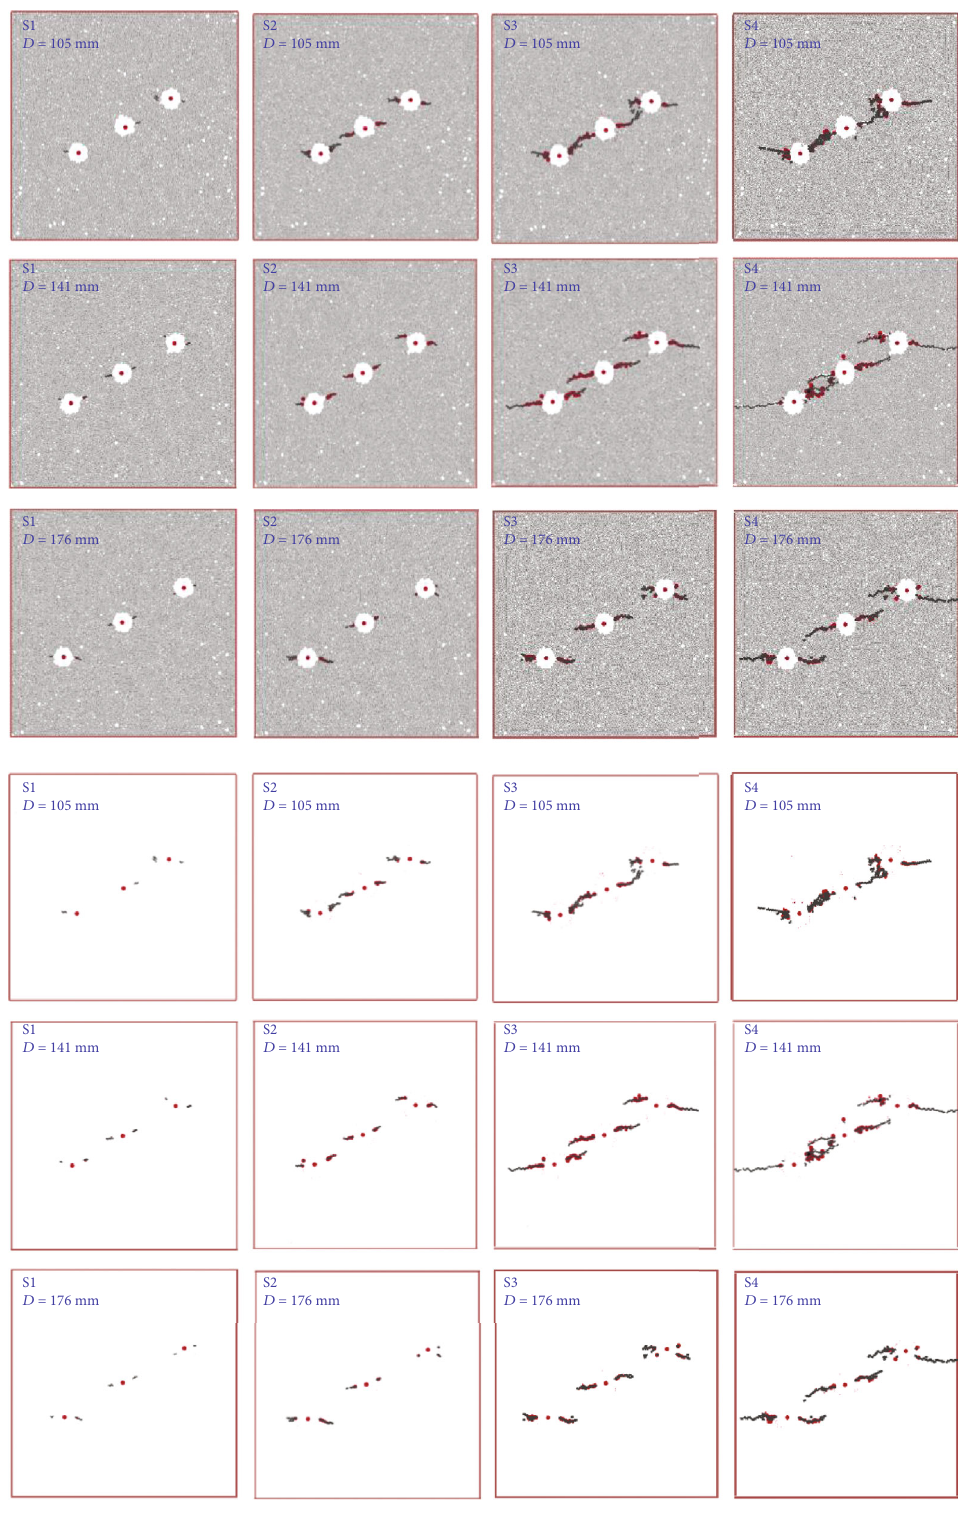
Figure 15: Initiation and propagation process of directional hydraulic fractures at di ff erent borehole direction of the maximum principal stress. The hydraulic 4000 time steps, the water began to be injected into the outer fractures of the H1 rightwing and H3 leftwing initiated and borehole. The hydraulic fractures of H1 leftwing and H3 expanded along the borehole line. Under the e ff ect of the rightwing extended to the edge of the test block along the